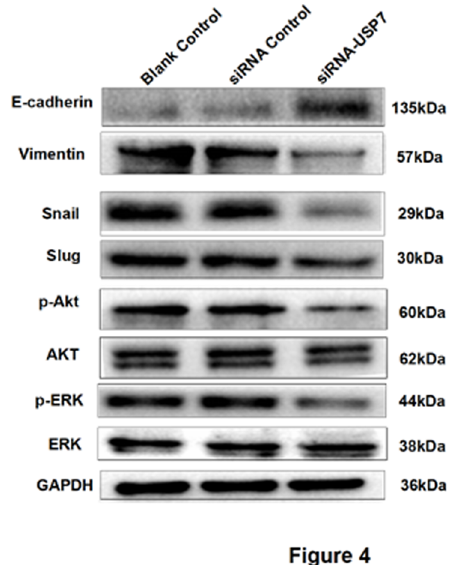
Figure 4 – USP7 induces EMT of OSCC cells via driving the Akt/ERK signaling pathway. The expression of E-cadherin, vimentin, Snail, Slug, ERK and AKT pathway proteins in HSC3 cells with USP7 siRNA or siRNA negative control, blank control were determined by WB. GAPDH expression was used as a